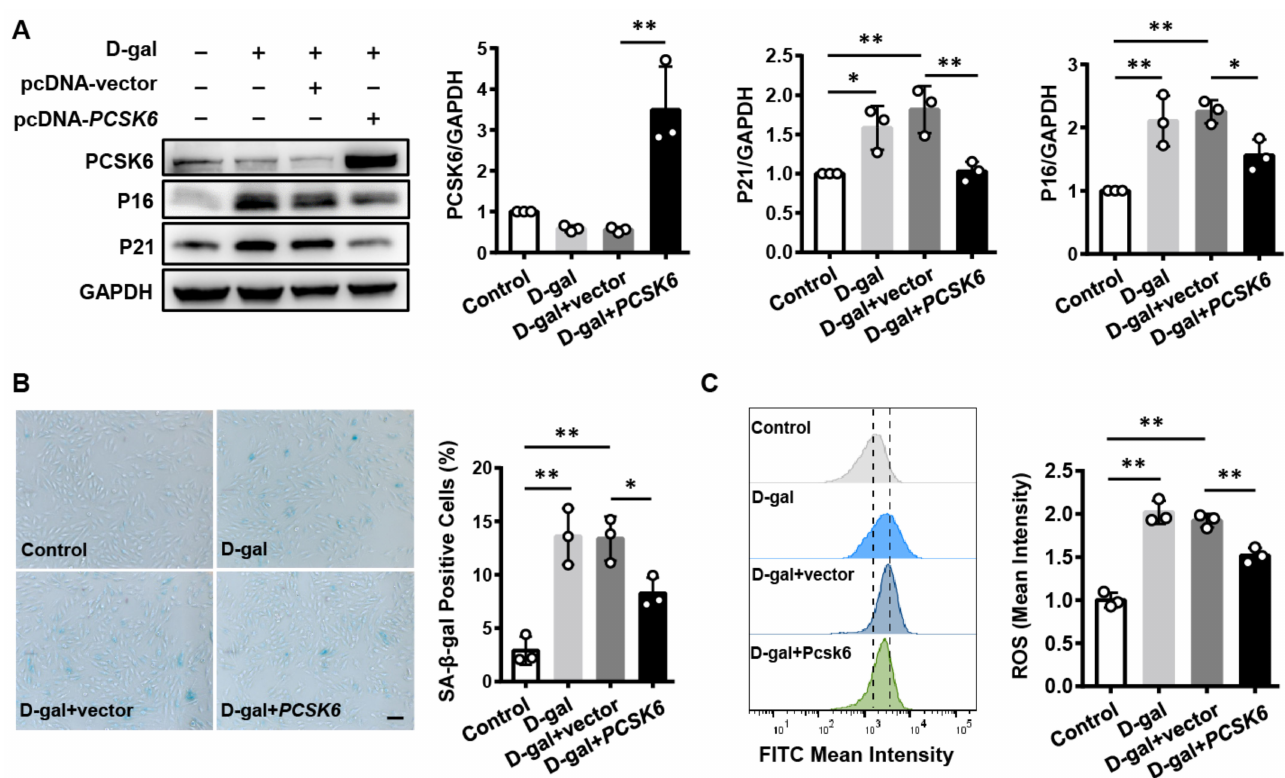
Figure 5. Reverse of cardiomyocyte senescence and dysfunction by PCSK6 overexpression. ( A ) West- ern blot analysis of PCSK6, P16 and P21 expression in H9c2 cells treated with D-gal and followed by transfected with a PCSK6 expression plasmid. Protein levels, normalized to GAPDH, were assessed by densitometry. ( B ) SA- β -gal staining in D-gal-treated H9c2 cells and transfected with a PCSK6 expression plasmid. Scale bar: 100 µ m. Percentages of blue-stained cells were estimated. ( C ) ROS levels in H9c2 cells treated with D-gal and followed by transfected with a PCSK6 plasmid were analyzed using flow cytometry with the FITC channel. Values are mean ± S.D. * p < 0.05, ** p < 0.01 vs.